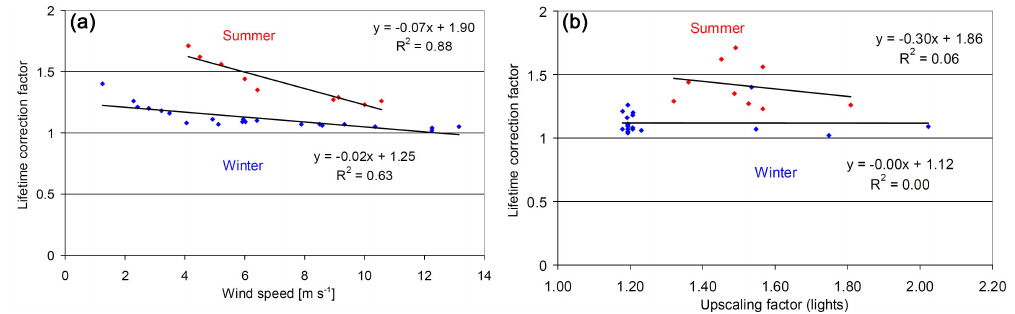
Figure A6. Dependence of the lifetime correction factor on wind speed (a) and the size of the circle ( b , represented by the upscaling factor).